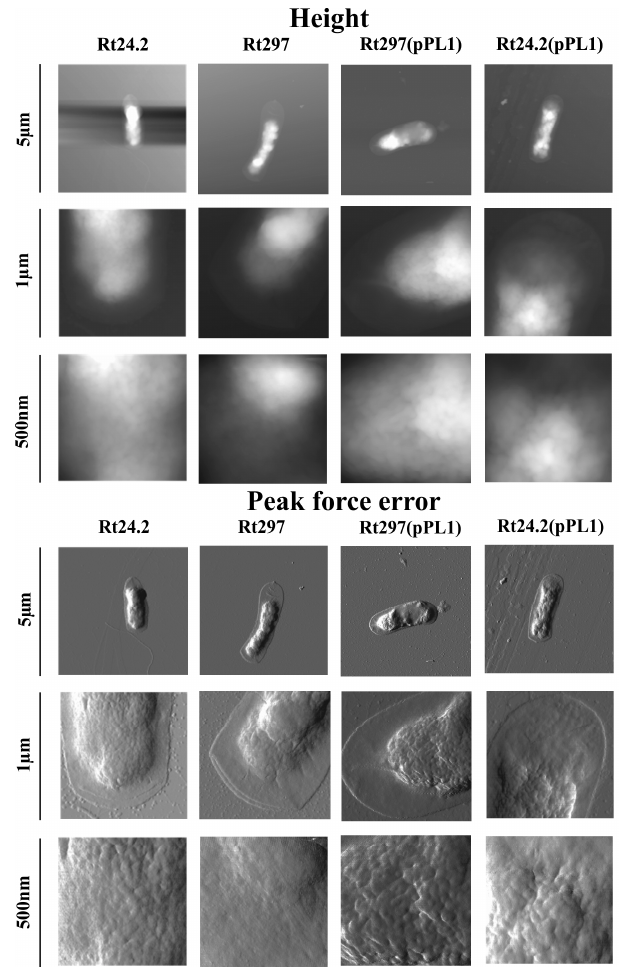
Figure 8. AFM imaging of the wild-type strain R. leguminosarum Rt24.2 and its derivatives Rt297, Rt297(pPL1), and Rt24.2(pPL1). The height and peak force error images are presented. The brighter and darker image areas correspond to the higher and lower parameter values, respectively. Table 3. Cell properties of the wild-type R. leguminosarum Rt24.2 and its derivatives determined using AFM analysis.